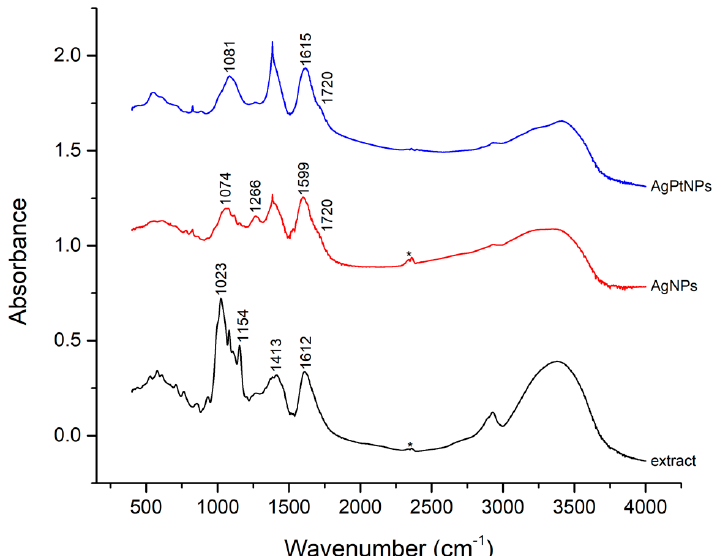
Figure 5. FT − IR spectra of basil extract (without NPs), AgNPs extract, and AgPtNPs extract. The star refers to carbon dioxide.